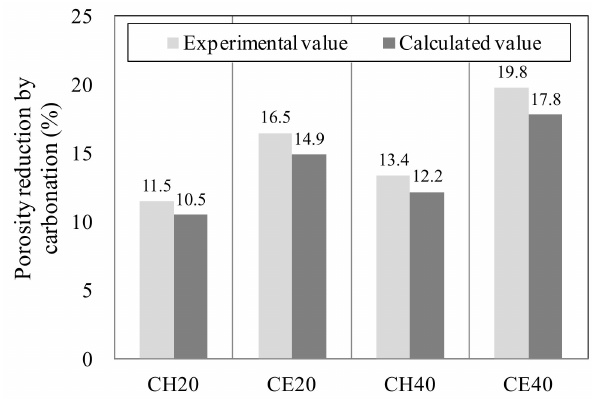
Figure 9. Porosity reduction by carbonation (IV